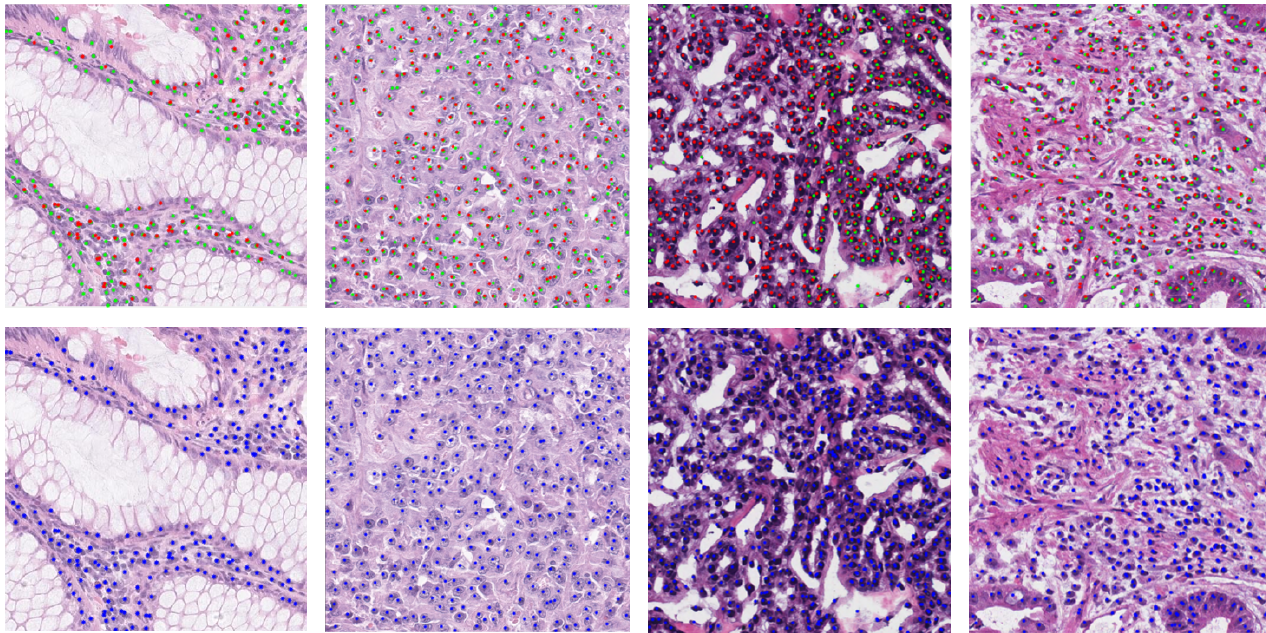
Figure 8. Examples of centroid detection on the validation sets V1 and V4. ( Top row ) Green, NDG- CAM method detections; red, Mask R-CNN detections. ( Bottom row ) Blue, combined method detections. First and second columns show data from V4, whereas the third and fourth columns depict data from